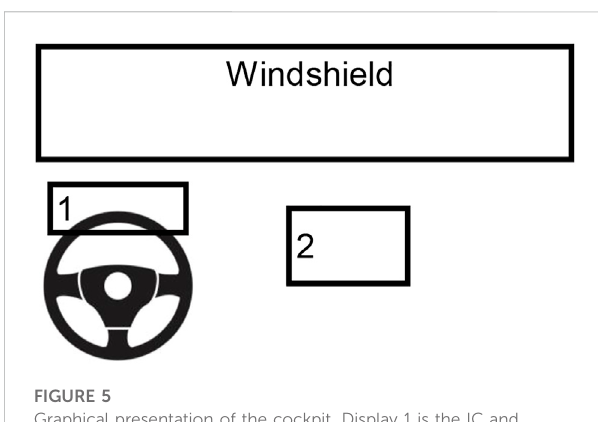
FIGURE 5 Graphical presentation of the cockpit. Display 1 is the IC and display 2 the